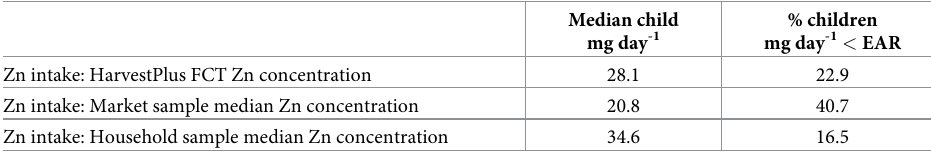
Table 4. Prevalence of inadequate dietary Zn